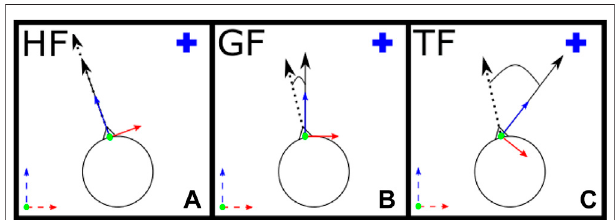
FIGURE 1 | Illustration of different frames of reference. In all cases, a head independent global coordinate system is de fi ned by dashed lines in the lowerleftcornerandforsimplicitythegazevectorisassumedperpendicularto the ground plane. (A) a head forward frame of reference centered on the gaze center (HF_C) moves and rotates with the head, (B) A global forward frame of reference centered on the gaze center (GF_C) moves with the head but is always aligned with the global coordinate system and (C) a target forwardframeofreferencecenteredonthegazecenter(TF_C)moveswiththe headbutmaintains aforward axisalignedwiththevectorfromthegazecenter to a speci fi ed target center.